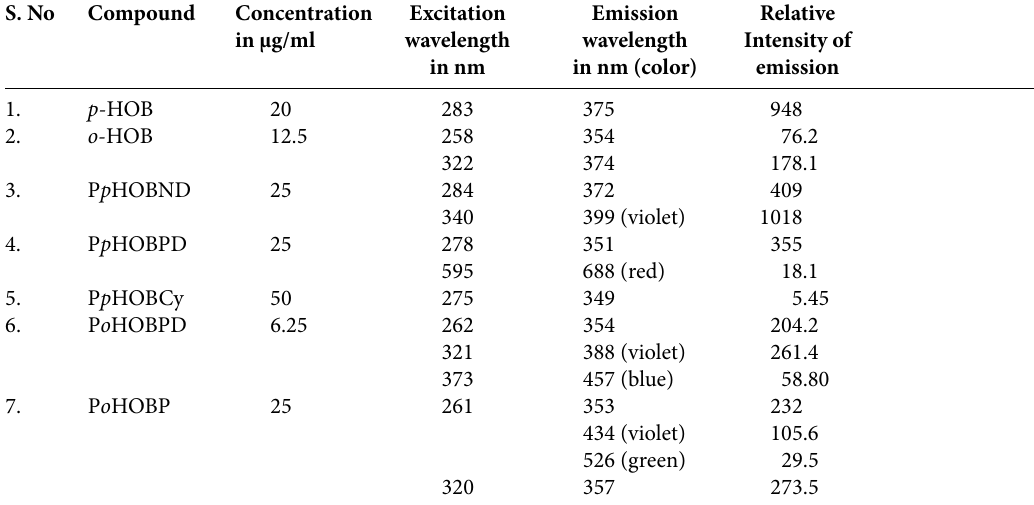
Table 3 : Spectrofluorometric determination of monomers and polymers using DMSO solvent S.